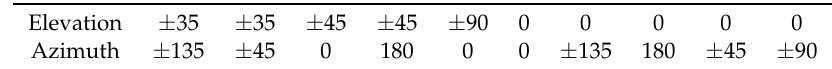
Table 2. Azimuth and elevation angles in degrees used for 26-point Lebedev Quadrature layout.